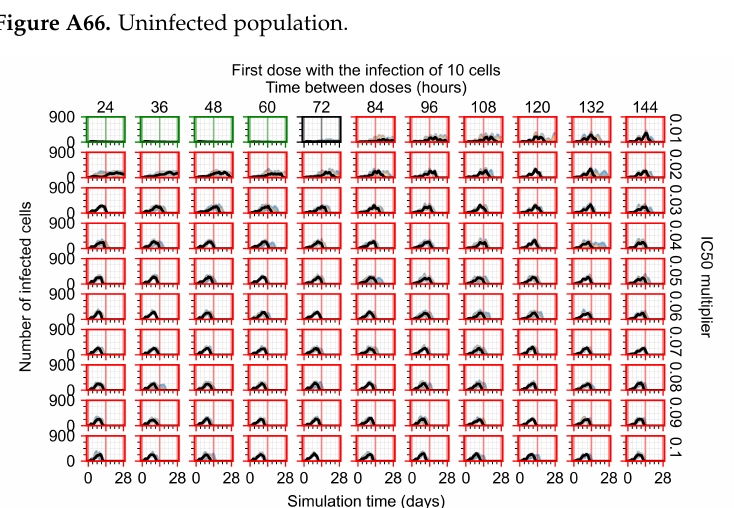
Figure A67. Infected (eclipse phase)